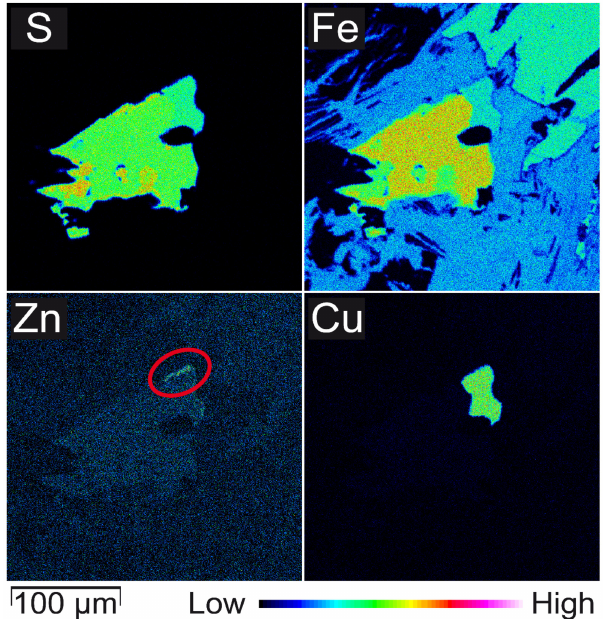
Figure 3. WDS elemental mappings (S, Fe, Zn, Cu) of a polyphase sulphide grain of sample B1 (compare with Figure 2b). A thin area characterized by elevated Zn contents is displayed in the upper right corner of the grain (red marking in Zn map). The main grain is an intergrowth of pyrrhotite and another Fe sulphide phase (pyrite?). Cu (combined with Fe and S) indicates